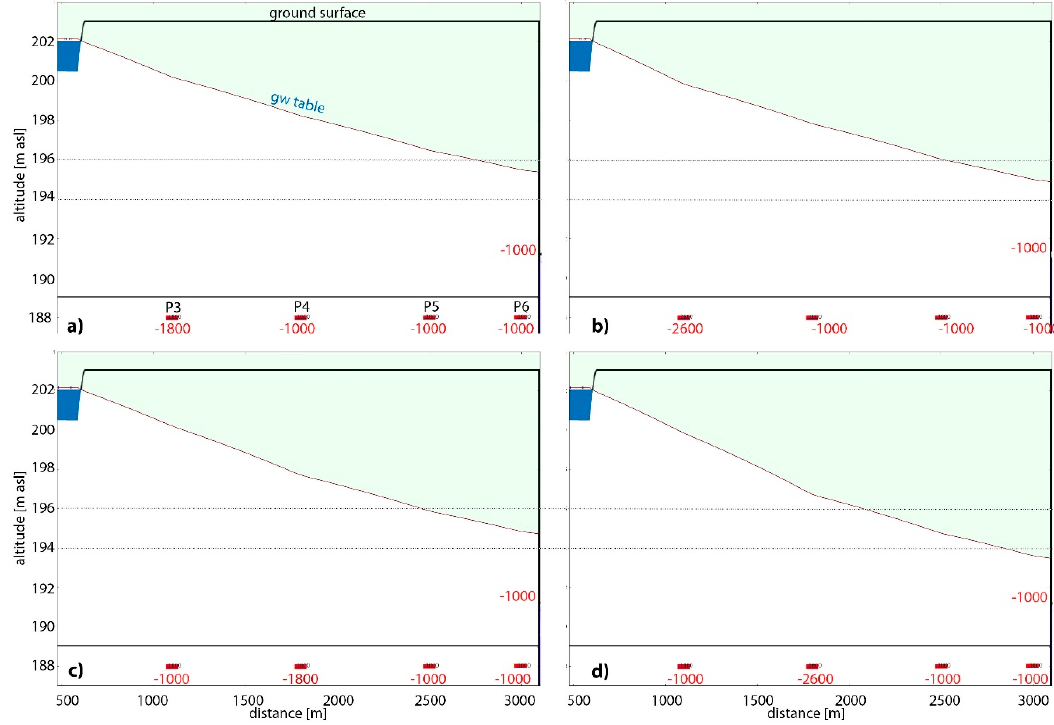
Figure 4. Effects of different pumping schemes on the groundwater levels. The water table decline is significantly smaller if the abstraction rates are increased in well P3 ( a , b ) instead of in well P4 ( c , d ). Table 5. Results of different pumping scenarios applied in models 3 and 4 (grid spacing of 2 m in the x-direction).